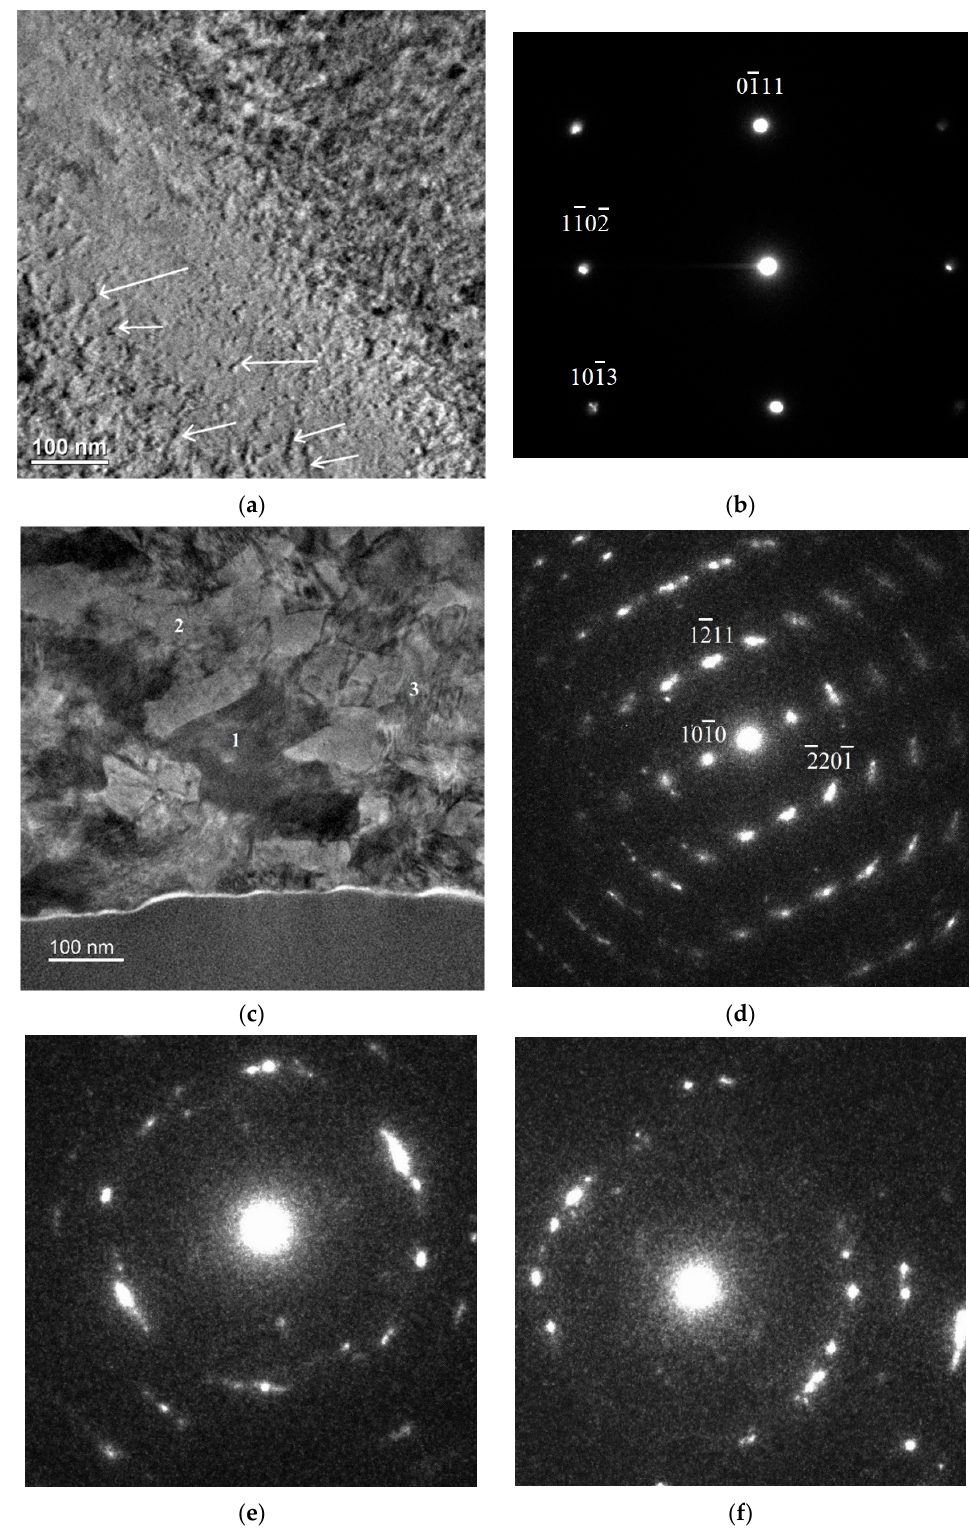
Figure 9. ( a ) TEM BF micrograph of the FSWed material taken near <5143> Z.A.; ( b ) SADP of <5143> Z.A.; ( c ) BF image of the FSWed material taken near <1216> Z.A.; ( d ) SADP of <1216> Z.A.; ( e ) SADP of grain 2; ( f ) SADP of grain 3.